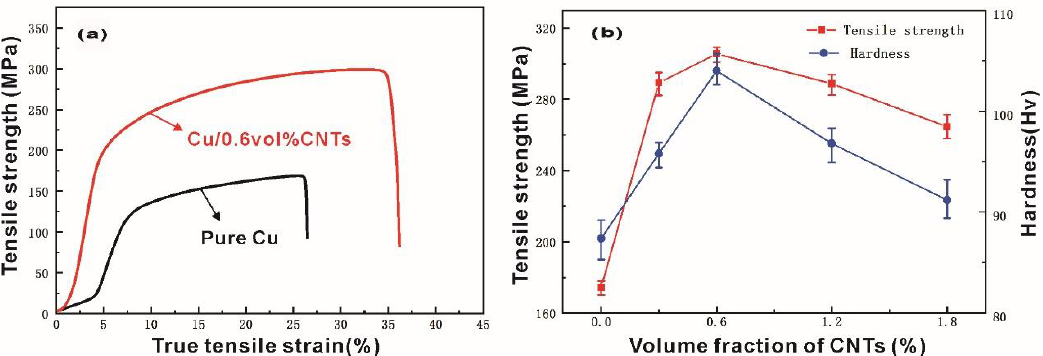
Figure 5. Mechanical properties of pure Cu and Cu / CNT composites: ( a ) typical quasi-static stress–strain curves and ( b ) tensile strength and Vickers hardness.